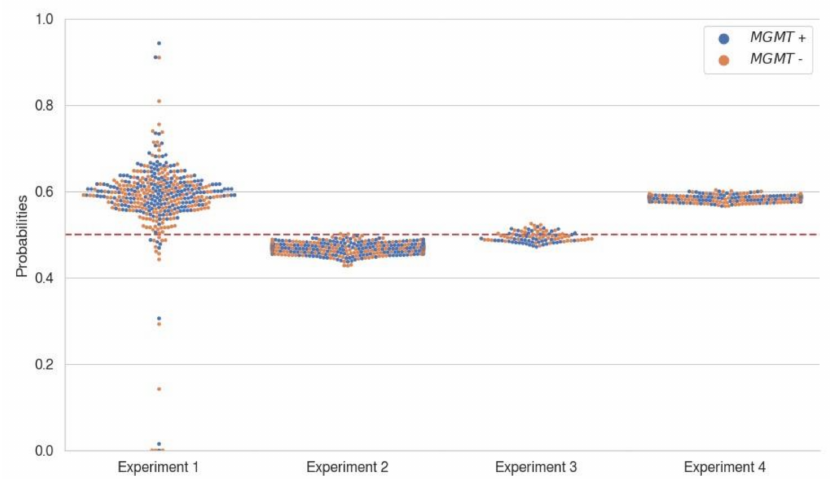
Figure 3. Probability score distribution according to the MGMT labels. The probability scores were predicted from the best model of each experiment (specified in Table 4) and obtained using the test set specific to each experiment. Note that there is no noticeable boundary in the distribution of data points between the groups with high and low probability scores, according to MGMT labels, which are indicated as different colors. MGMT+ (blue) indicates the methylated MGMT promotor group, and MGMT- (orange) indicates the unmethylated MGMT promotor group. The red dotted lines indicate chance level. Abbreviations: MGMT, O6-methylguanine-DNA